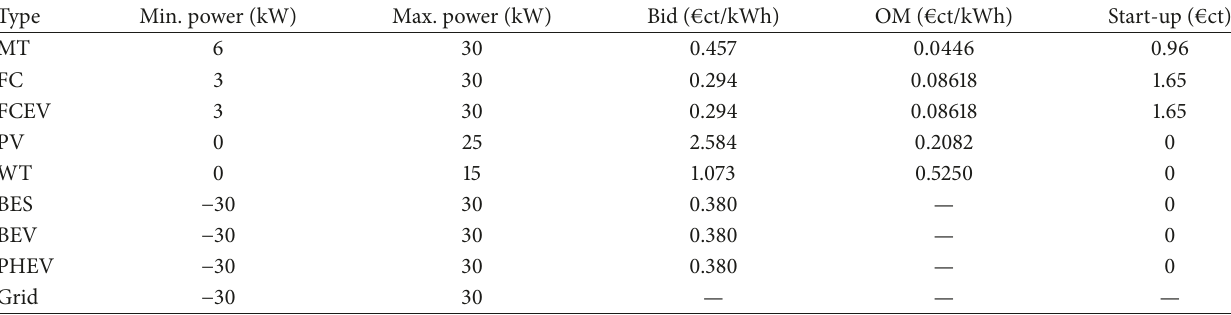
Table 5: The constraints limit and bids of the DGs, utility, BES, and